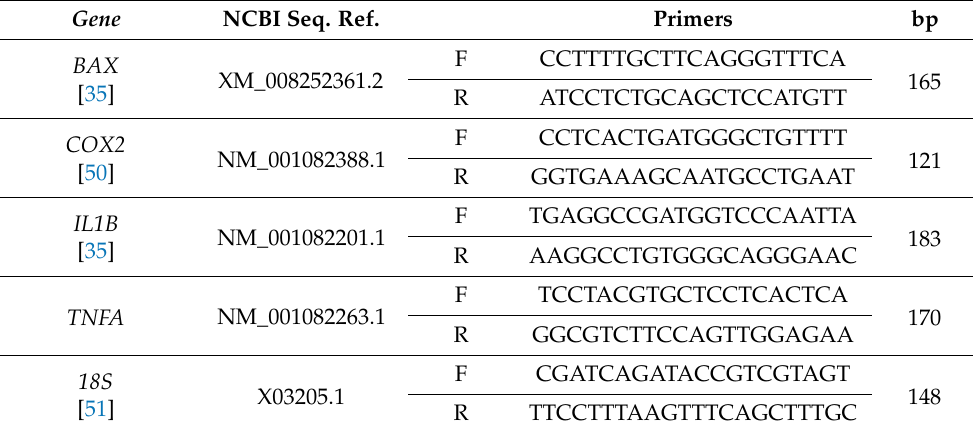
Table 2. Primers used for gene quantification by RT-qPCR.